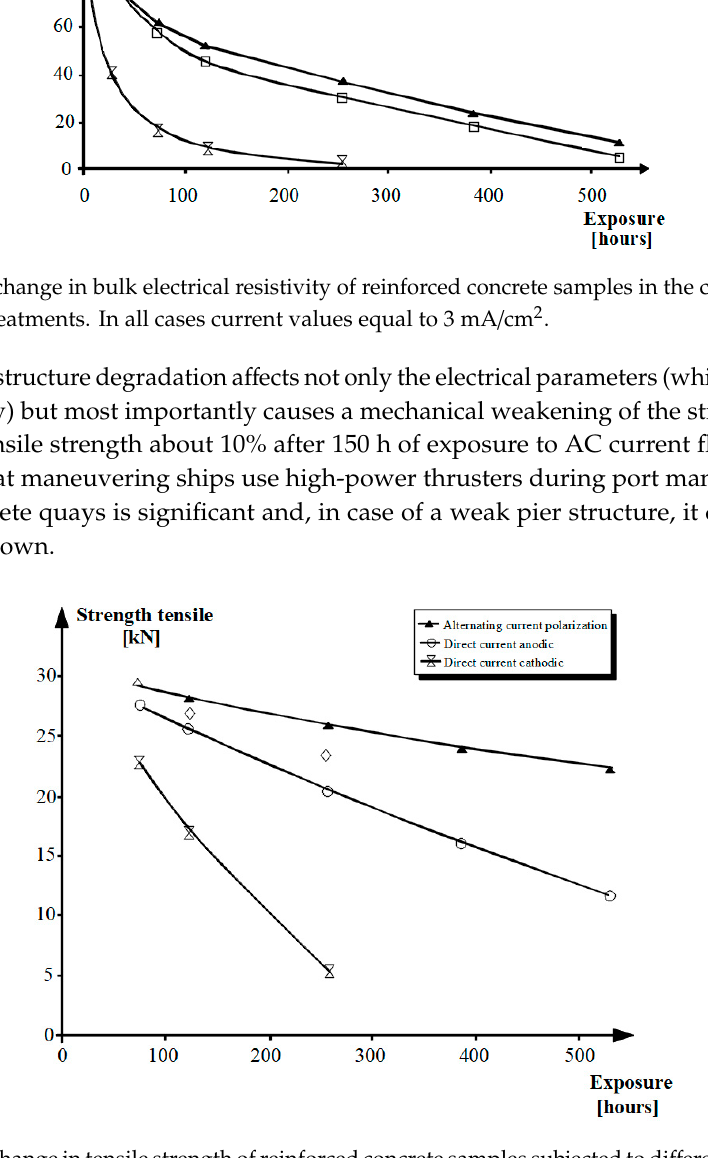
Figure 3. The change in tensile strength of reinforced concrete samples subjected to different polarization treatments. In all cases current values equal to 3 mA/cm 2 .